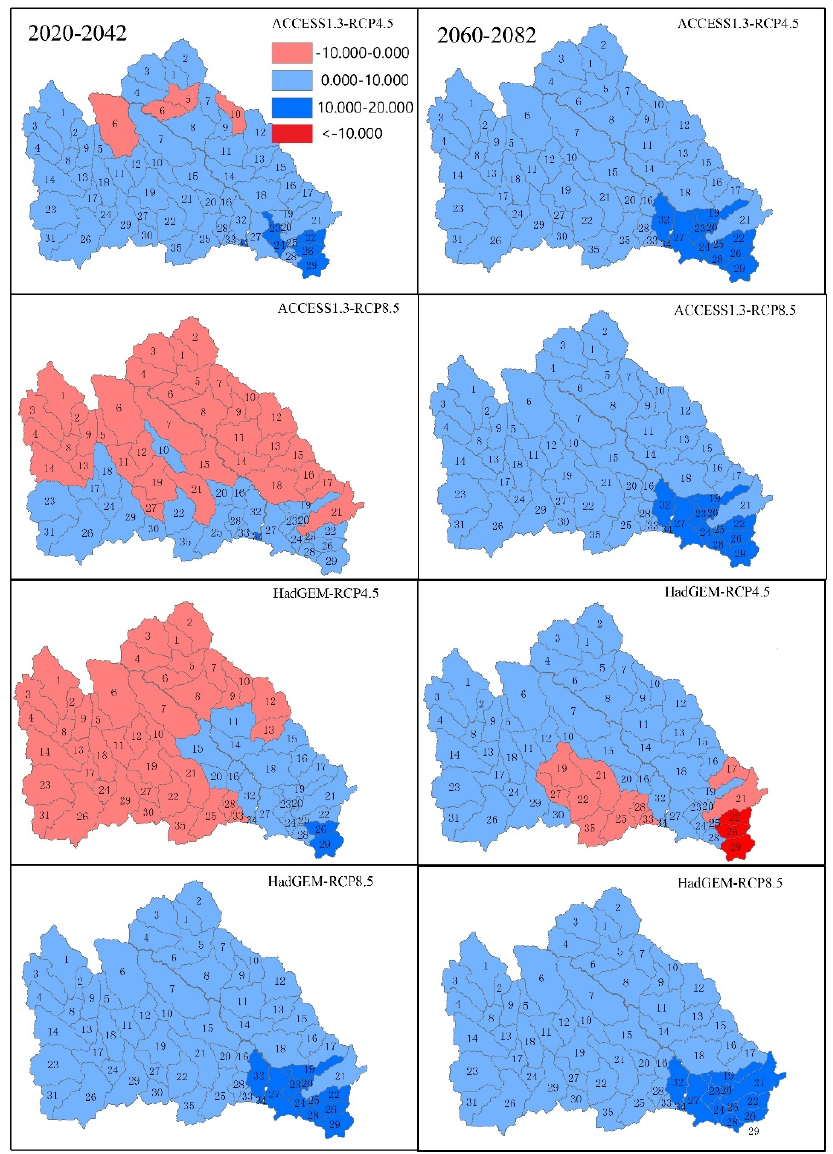
Figure 9. Spatial distribution of water yield under different climate change projections.